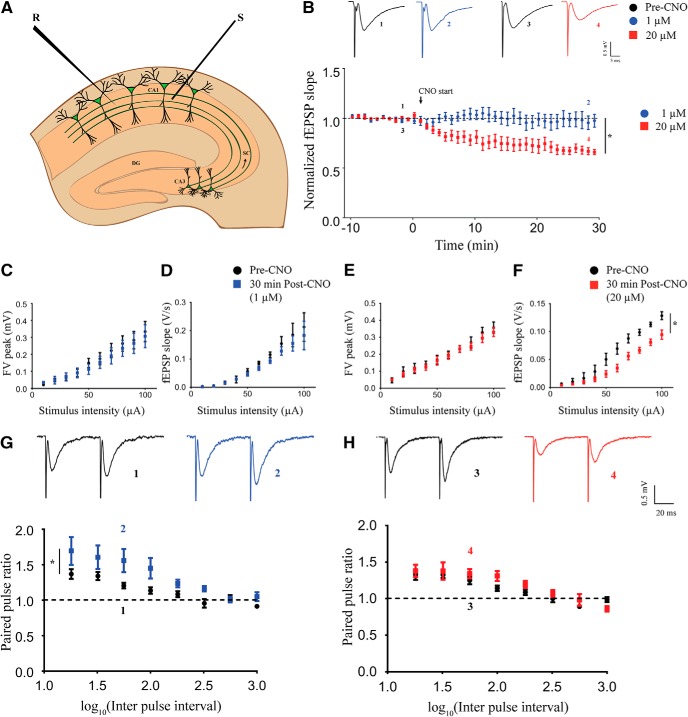
Acute chemogenetic activation of hippocampal excitatory neurons differentially regulates field transmission in Schaffer collaterals in a dose-dependent manner. A, Shown is a schematic of placement of stimulating and recording electrode in the Schaffer collaterals. B, Shown are representative fEPSP traces before (1) and 30 min (2) following 1 μM CNO treatment and representative fEPSP traces before (3) and 30 min (4) following 20 μM CNO treatment. Refer to Extended Data Fig 2-1 for genotype-controls and bath application of 1 μM, 5 μM, 10 μM, and 20 μM CNO. Refer to Extended Data Fig 2-2 for fEPSP time-course following CNO-washout. Bath application of CNO did not affect fEPSP time course at 1 μM, whereas it led to LTD of fEPSP at 20 μM. Stimulus intensity: 50–80 μA; 20–30 μs. The FV peak was not altered with increasing stimulus intensity either at 1 μM (C) or 20 μM (E). The fEPSP slope was not different at 1 μM (D), but significantly lower in response to increasing stimulus intensity at 20 μM (F). G, Shown are representative paired-pulse-evoked fEPSP traces before (1) and 30 min (2) following 1 μM CNO treatment. A significant potentiation of PPR was observed (G) following 30 min of 1 μM CNO bath application. H, Shown are representative paired-pulse-evoked fEPSP traces before (3) and 30 min (4) following 20 μM CNO treatment. No significant alteration in the PPR was noted following 30 min of 20 μM CNO bath application (H). Results are expressed as the mean ± SEM; *p < 0.05 as compared between 1 and 20 μM CNO treatment (linear regression followed by ANCOVA). S: stimulating electrode; R: recording electrode.